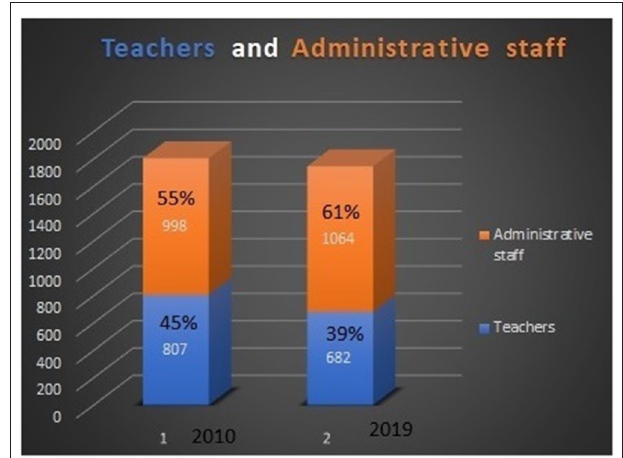
FIGURE 1 | The ratio of teachers and administrative staff in the University of Miskolc.